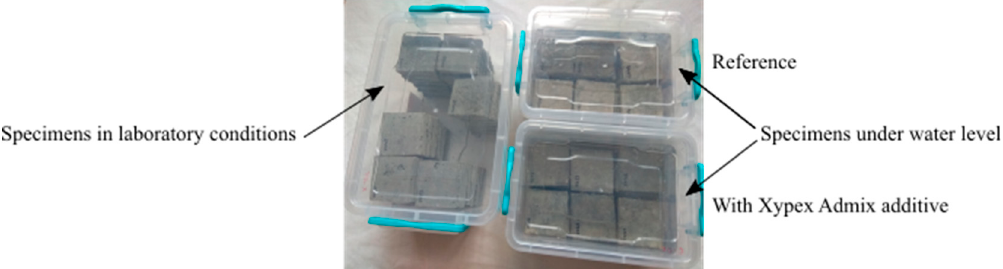
Figure 5. Storage of test specimens in the second phase.